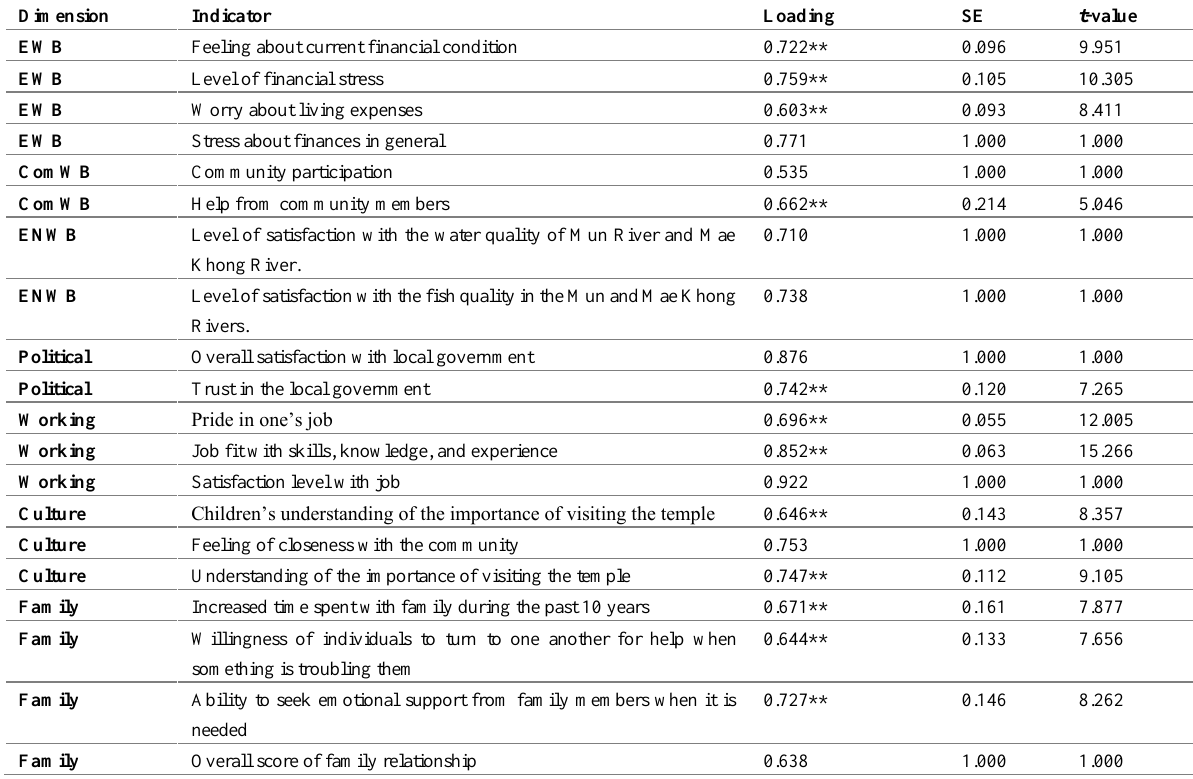
Table 4: Standardized factor loadings for indicators of the seven well-being dimensions in the CFA model.